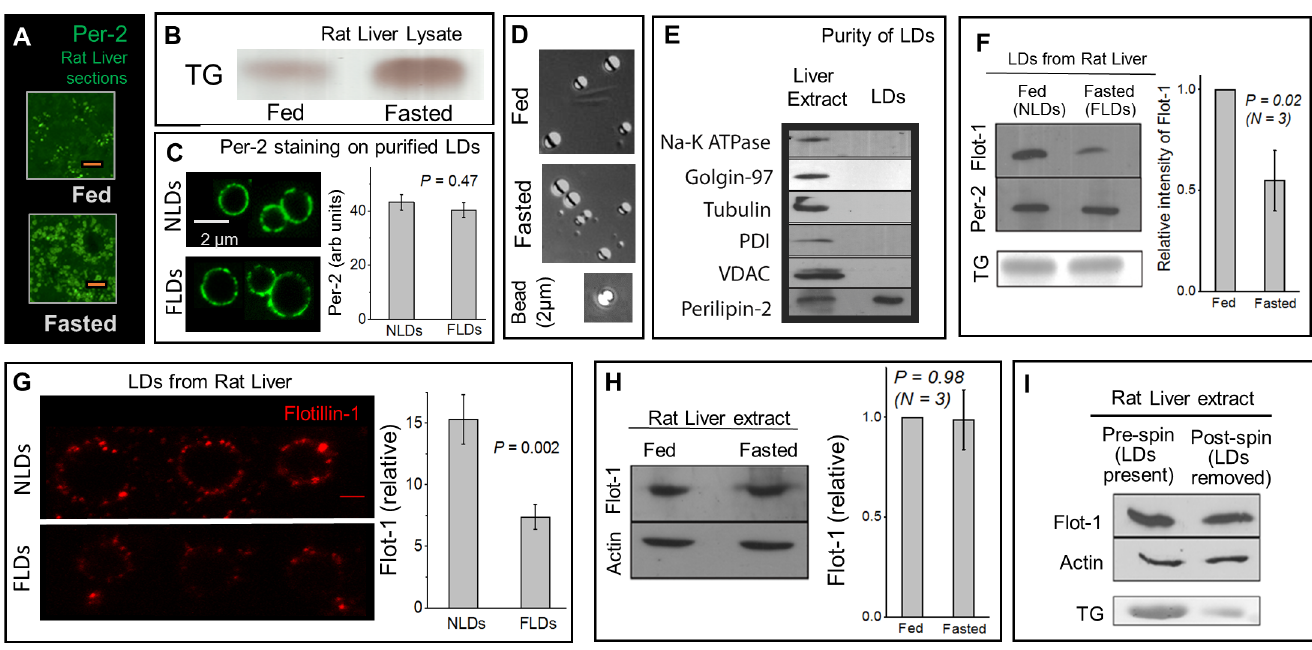
Fig 1. Flotillin-1 binding to LDs purified from liver is reduced in fasted state. (A) Immunostaining of LDs using anti-perilipin-2 antibody on liver tissue sectionsfrom fed and fasted rats. There is a drastic increase in numberof LDs after 16 hours of fasting. Scale bar = 10 μ m.(B) TLC showing significantly higherTG levels in rat liver lysate after 16 hours of fasting. (C) Stainingof purifiedNLDs and FLDs using a perilipin-2 antibody.There is no difference in the amount of perilipin-2 on NLDs and FLDs at the single-LDlevel. Panel on right quantifiesthe changes.30 LDs used per condition. Error bars are SEM. (D) DIC image of LDs purifiedfrom liver in fed and fasted state. A 2 μ m latex bead is also shown. There is no significantchange in the size of purified LDs betweenfed and fasted state (see main text). (E) The LD fraction isolatedfrom liver is free of detectablecontamination from PM (Na-K ATPase used as marker), Golgi (Golgin-97),cytosolic (tubulin),ER (PDI) and mitochondrial (VDAC-1). Liver extract is loadedas a positive control. The LD fraction is enrichedin perilipin-2 (LD marker). (F) Flotillin-1is detected on LDs isolatedfrom liver of normally fed rats (NLDs) and fasted rats (FLDs) by Western blotting. Flotillin-1levels reduceon LDs upon fasting. Equal loadingof NLDs and FLDs is confirmedfrom equal perilipin-2 levels (by Western blotting) and equal TG (by TLC) in these samples. Right panel quantifies the changes.Error bars are SEM. (G) Flotillin-1staining on isolatedNLDs and FLDs. Representative LDs of comparablesize from each sample are shown. Scale bar is 2 μ m. Right panel shows the flotillin-1 fluorescence intensity (mean ± sem) measuredalong circumference of individualNLDs and FLDs (15 of each used). (H) Flotillin-1level does not change significantly in liver tissue extract betweenfed and fasted state. This observationwas consistent in samples collectedfrom three pairs of animals. Western blotting against actin shows equal loadingof the liver extract samples. Error bars are SEM (I) Western blottingagainst flotillin-1of liver extract from fasted rat before and after depletionof LDs by centrifugation. No detectablereductionis seen in flotillin-1levels after removalof LDs (post-spin). Western blotting of actin shows equal loadingof the TE samples. Depletionof LDs from the liver extract is confirmed by reductionin TG levels through TLC.